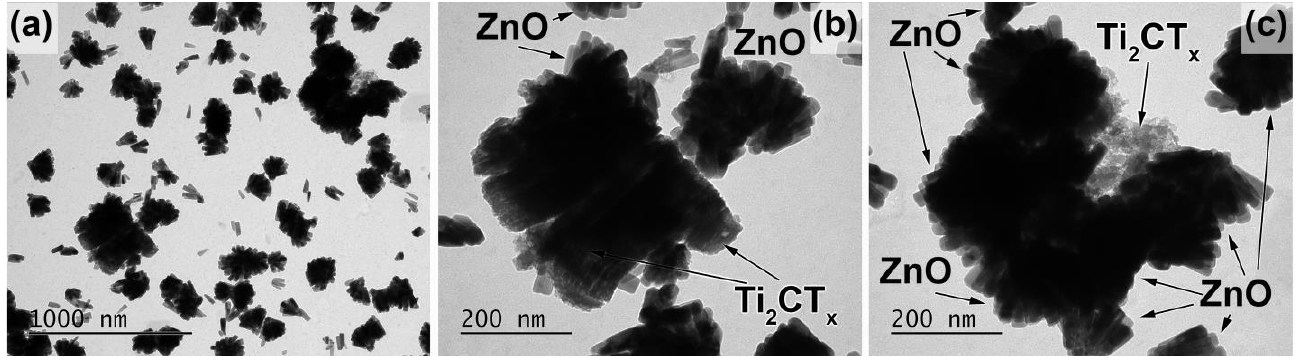
Figure 4. X-ray diffraction patterns of the obtained powders Z, Z1T, Z3T and Z5T ( a ) and Raman spectra of Ti 2 CT x MXene powders and Z and Z5T samples (b) .